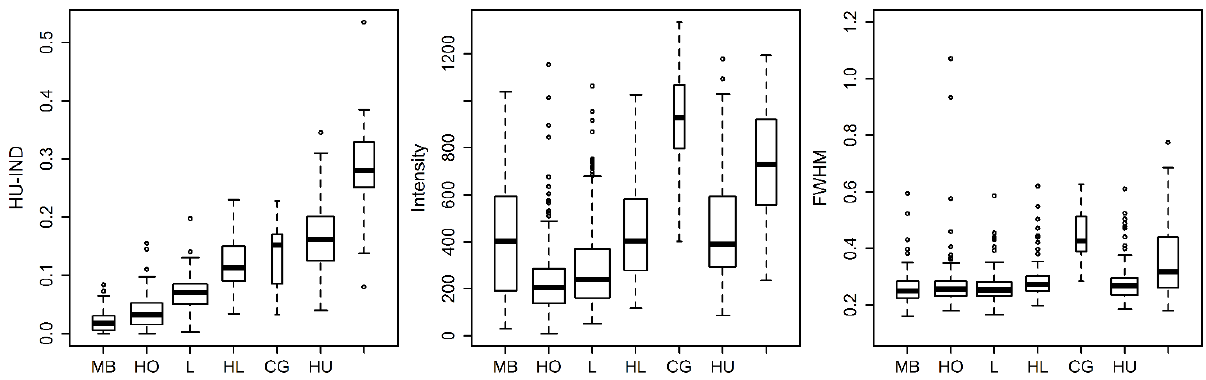
Figure 12. Boxplot graphs of three LiDAR features. FWHM refers to ECHOW